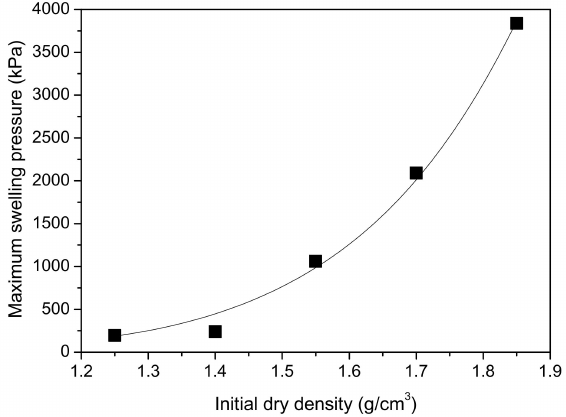
Figure 15. Relationship between maximum swelling pressure and initial dry density of MB specimen sunder saline water conditions.